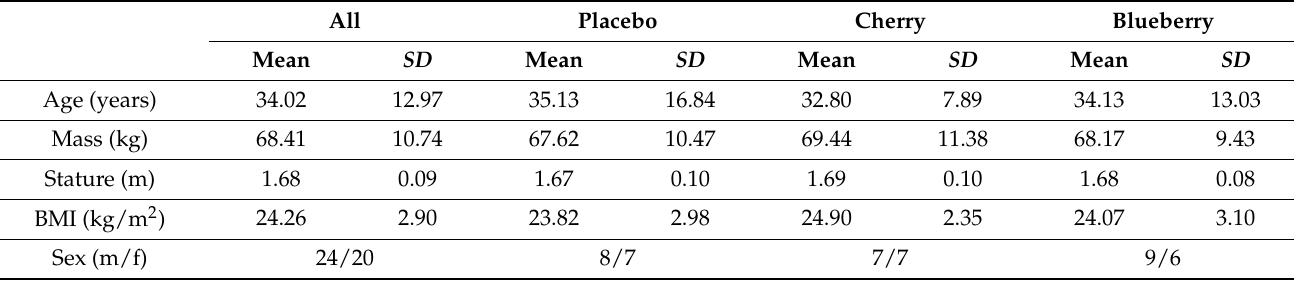
Table 1. Baseline characteristics of completed study